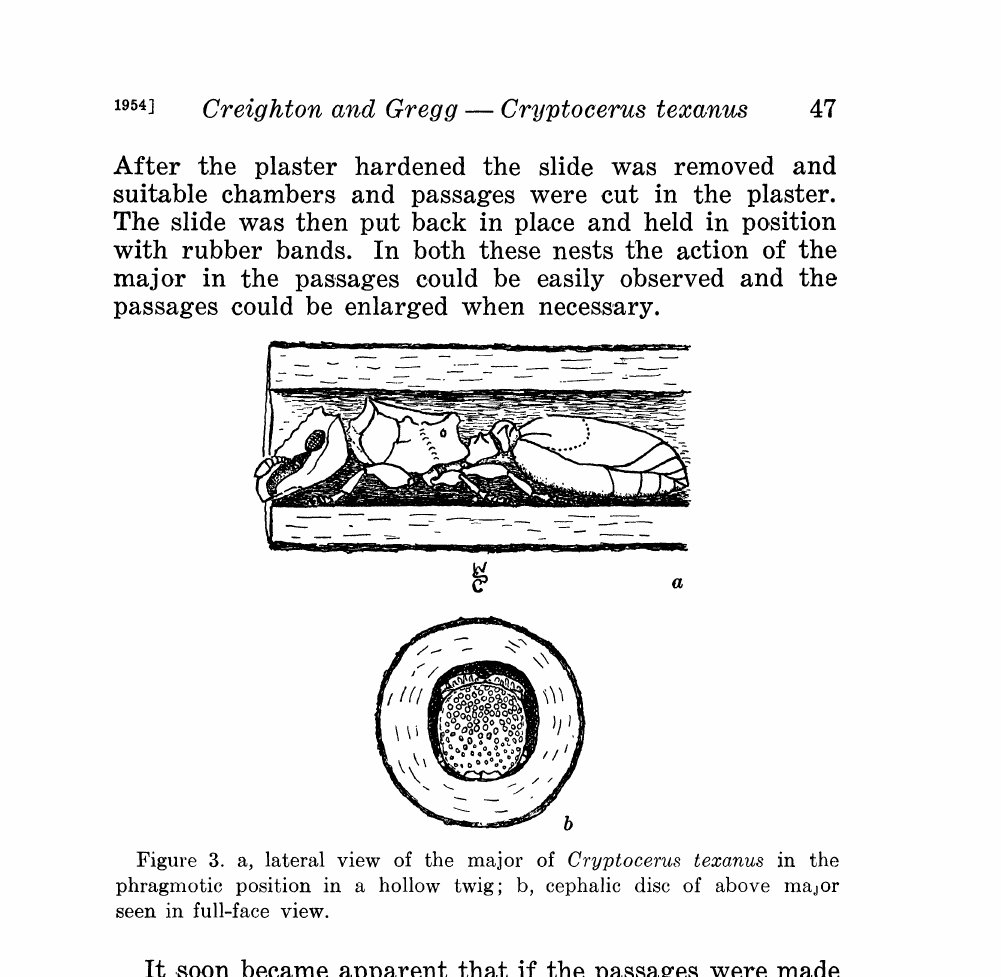
Figure 3. a, lateral view of the major of Cryptocerus texanus in the phragmotic position in a hollow twig; b, cephalic disc of above major seen in full-face